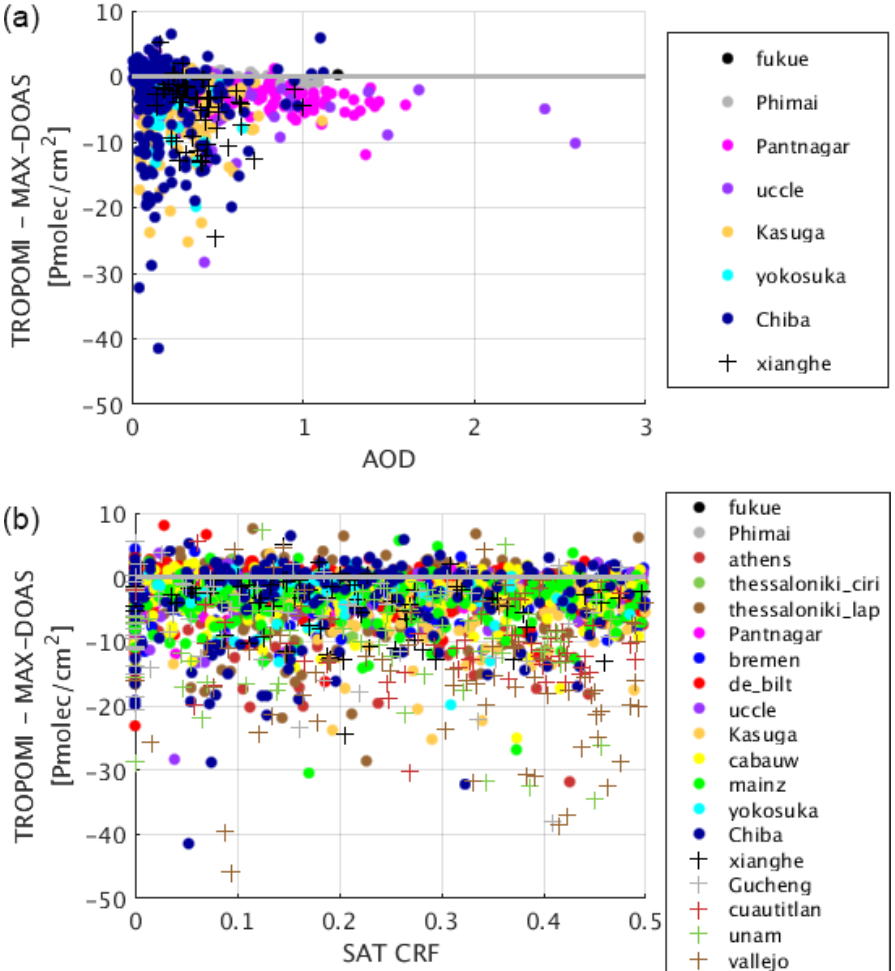
Figure 11. Dependence of the difference between TROPOMI OFFL and ground-based MAX-DOAS tropospheric NO 2 column data on (a) the MAX-DOAS-retrieved aerosol optical depth (AOD; only available for a subset of the instruments) and (b) the satellite cloud radiance fraction (CRF).